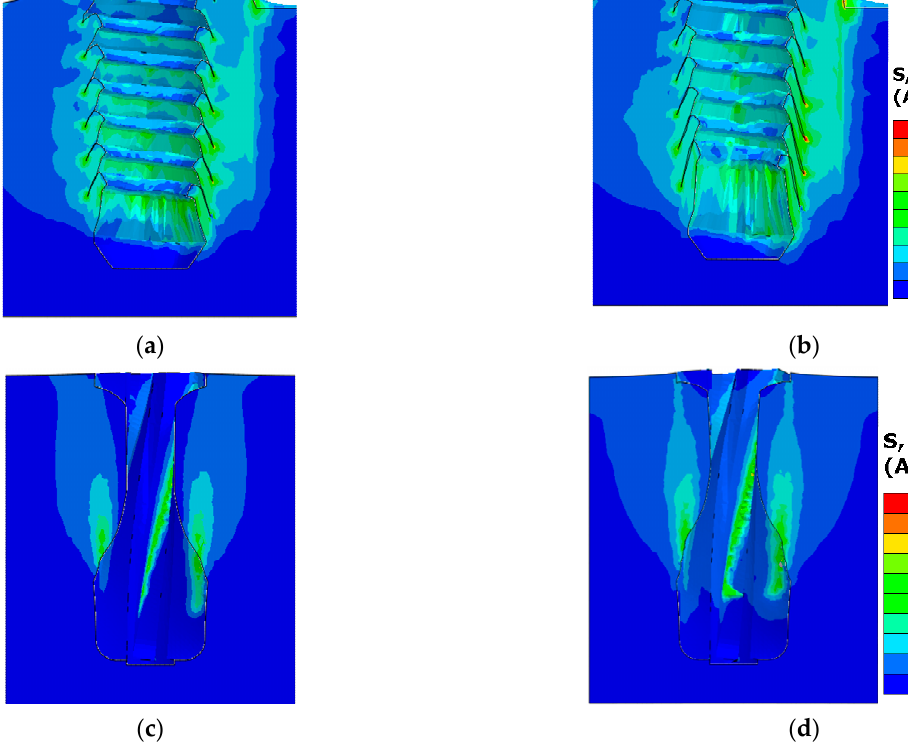
Figure 12. Distribution of von Mises equivalent stress (MPa) with increase of pull-out stroke in normal foam density (0.35 g/cm 3 ): ( a ) screw at pull-out stroke of 4 mm; ( b ) screw at pull-out stroke of 6 mm; ( c ) helical blade at pull-out stroke of 4 mm; ( d ) helical blade at pull-out stroke of 6 mm.